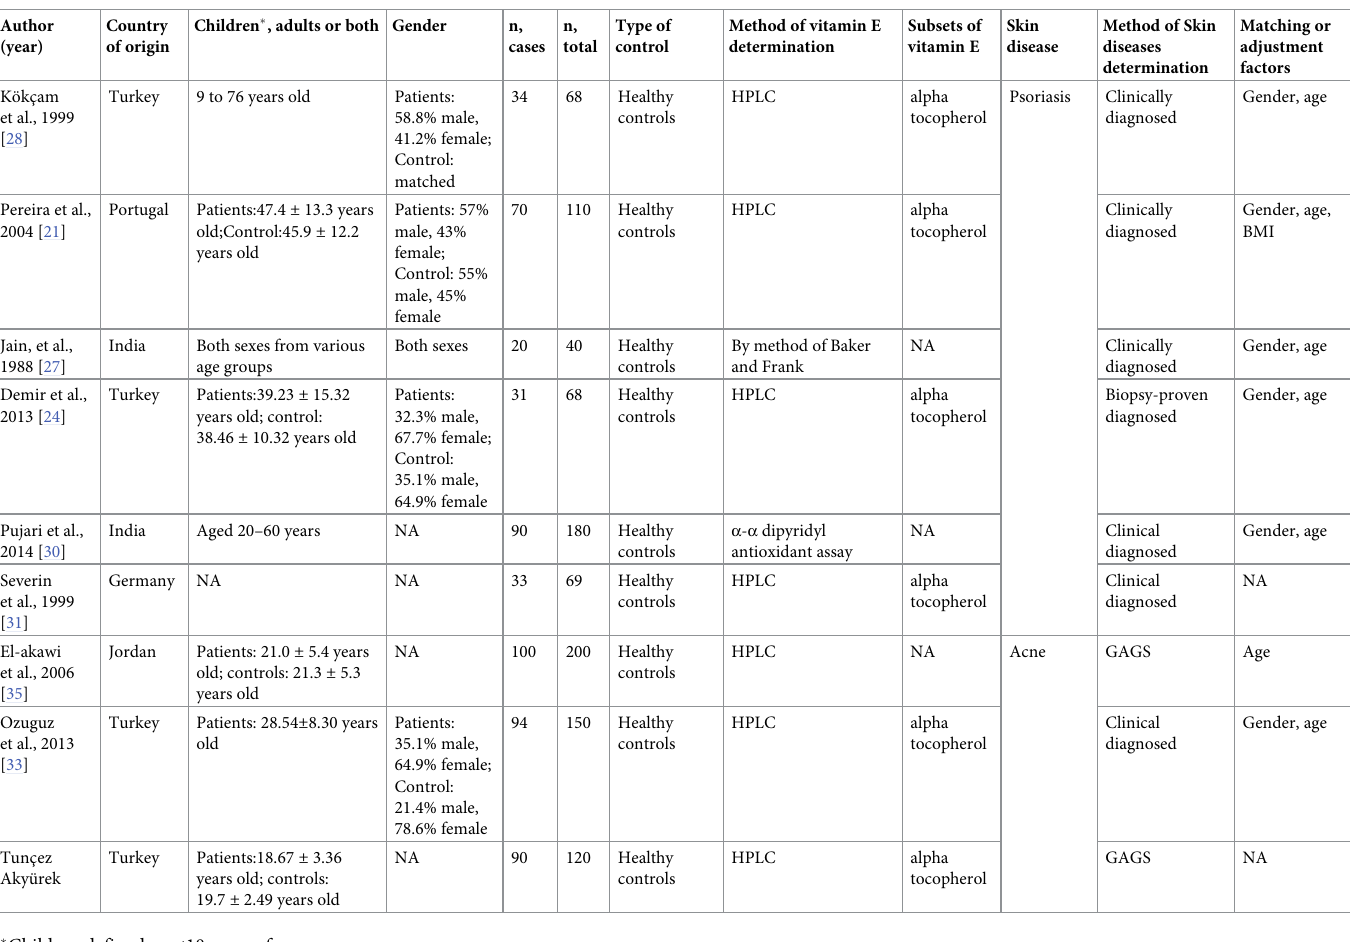
method of ascertainment for cases and controls, but only one study provided non-response rates or described non-respondents. Serum vitamin E levels and vitiligo Levels of serum vitamin E in patients with vitiligo were reported in 7 studies, with 351 cases and 350 controls in total (p < 0.001, I 2 = 90.4%). Compared with the control group, vitiligo patients had significant lower level of serum vitamin E (SMD: -0.70, 95% CI: -1.21 to -0.19) (Fig 2). No publication bias was detected by Egger’s test (p = 0.248). Serum vitamin E levels and psoriasis Six studies investigated the change of serum vitamin E levels in psoriasis, with a total of 278 cases and 257 controls (p < 0.001, I 2 = 97.6%). Compared with the control group,